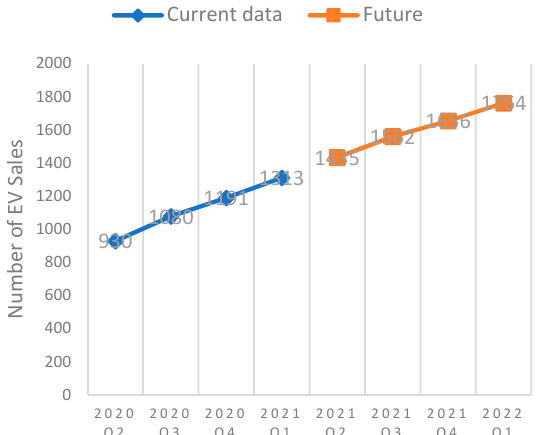
Figure 8. The trend of EVs licensed in County Durham.